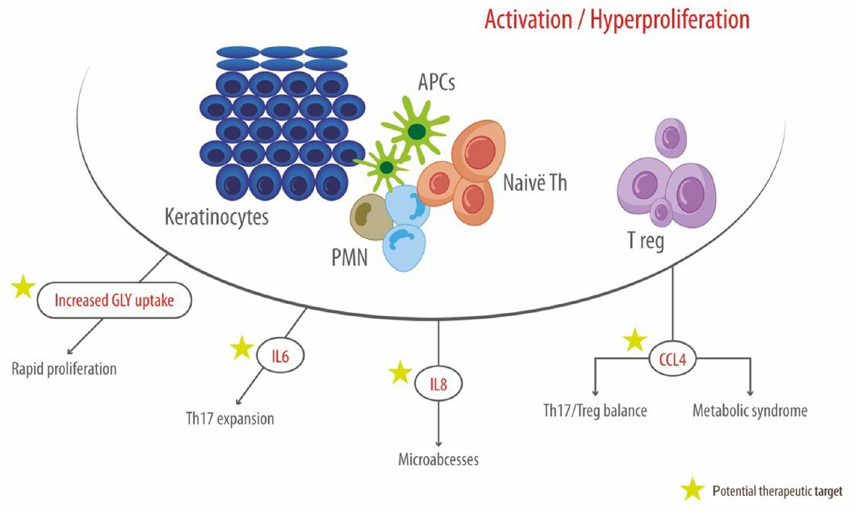
Figure 6. Candidate immune-metabolic signature of new-onset psoriasis. Figure produced by Adobe Illustrator 2020 (https:// www. adobe. com/ it/ produ cts/ illus trator. html). No permission